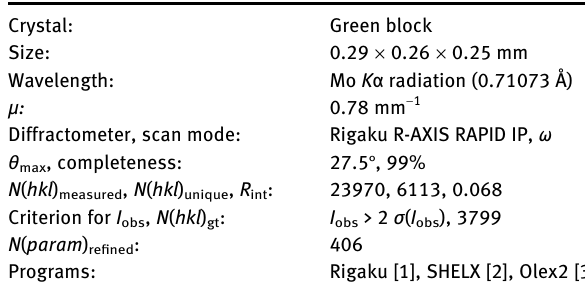
Table  : Data collection and